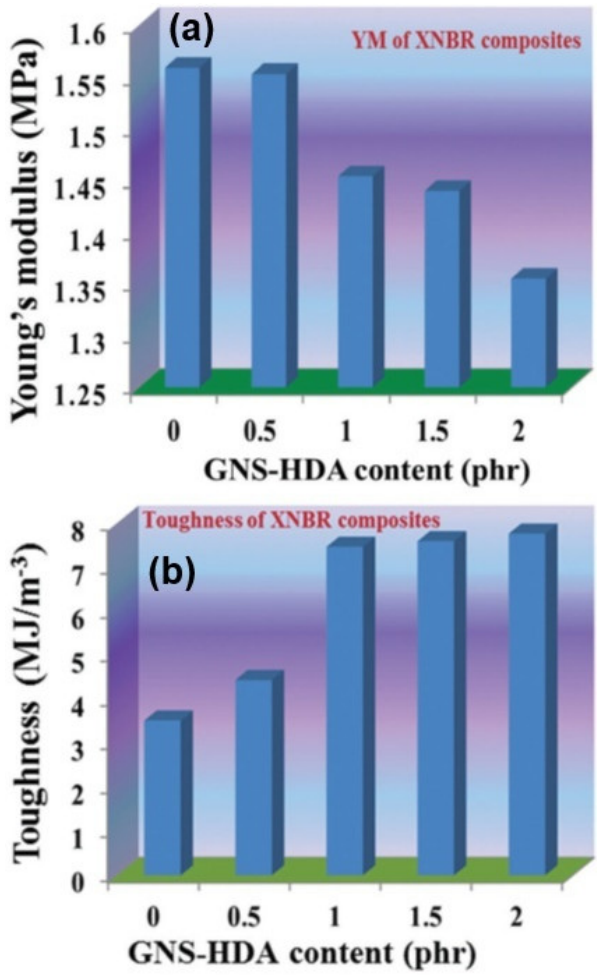
Figure 12. ( a ) Tensile strength and ( b ) elongation at break of neat carboxylated acrylonitrile butadiene rubber (XNBR) and various hexadecyl amine functionalized graphene (GNS-HDA)/XNBR composites. Reproduced with permission from [104], Copyright RSC, 2017.